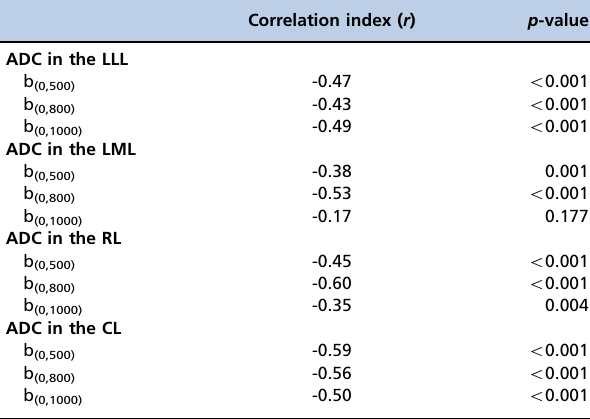
Table 3 - Relationship between the apparent diffusion coefficient ( (cid:1) 10 -3 mm 2 /s) and the Child-Pugh class of cirrhosis.